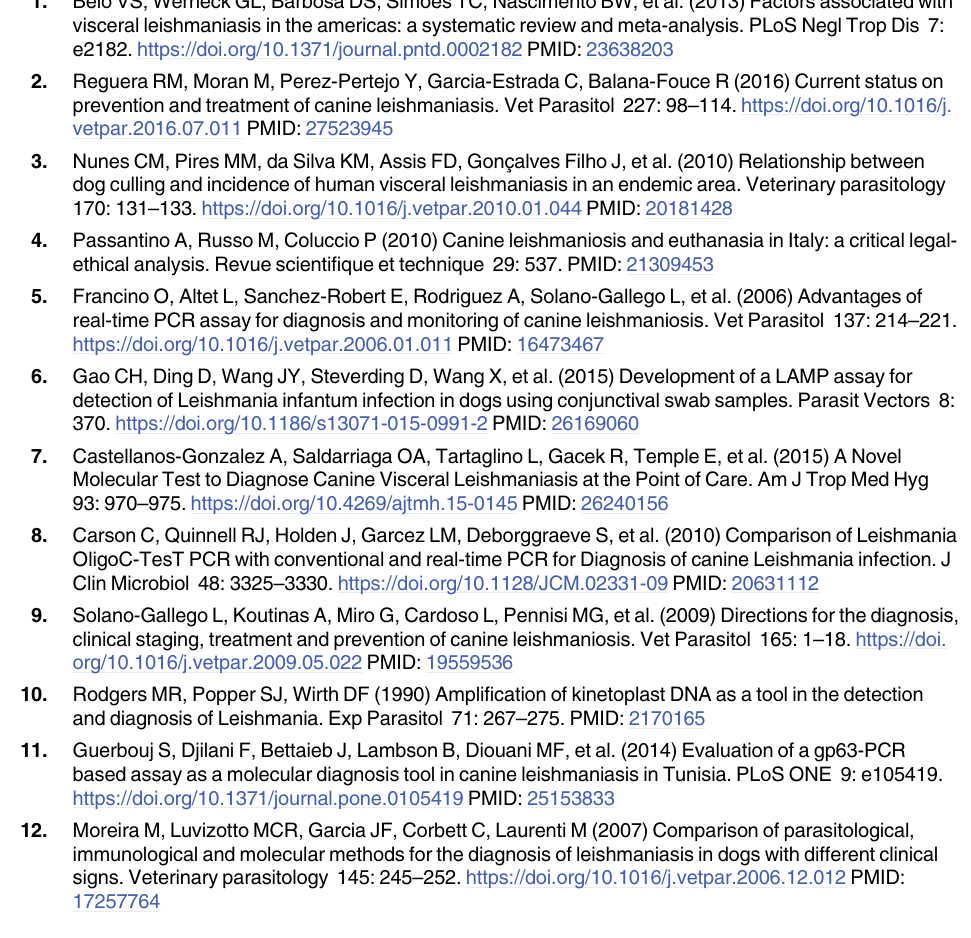
S1 Table. Molecular tests for diagnosis of canine visceral leishmaniasis. S2 Table. Serological tests for diagnosis of canine visceral